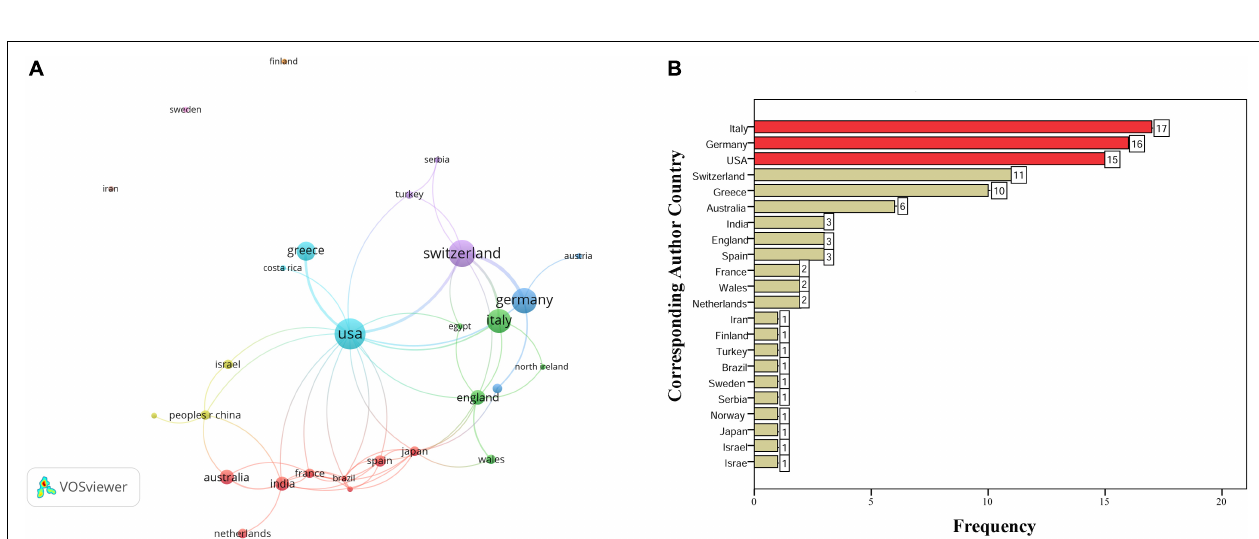
FIGURE 3 | Country distributions of the 100 most-cited papers. (A) The collaboration networks of all authors country, and (B) corresponding author country.